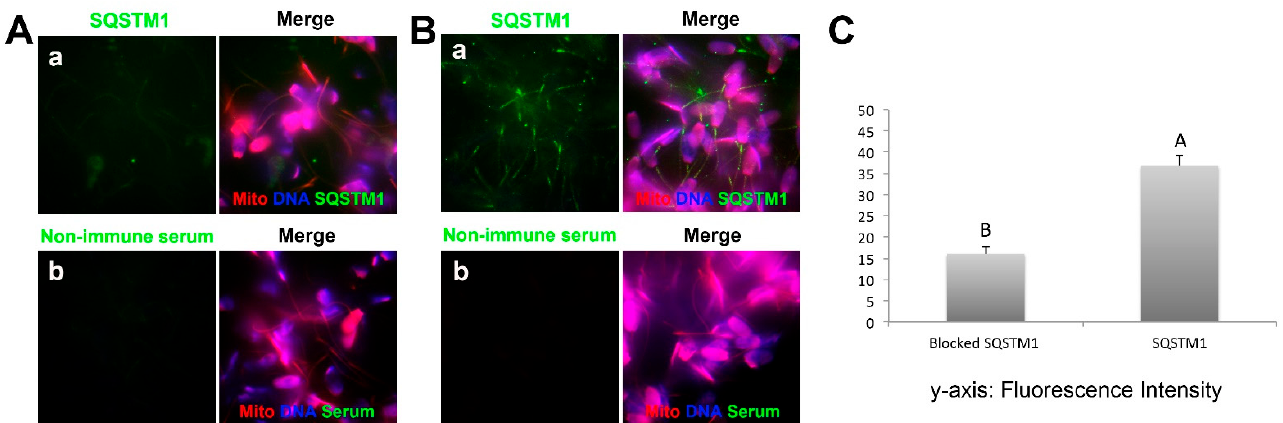
Figure 6. Inclusion of an isospecific antibody into sperm-oocyte extract co-incubation mixture prevents the binding of ooplasmic SQSTM1 to sperm mitochondria. Spermatozoa treated with lysolecithin and DTT were co-incubated with porcine oocyte extracts for 4 h with or without the addition of anti-SQSTM1 antibody, then washed and processed for immunofluorescence with the same antibody or with non-immune mouse serum (control). Such treatment prevented oocyte-extract derived SQSTM1 from binding to sperm mitochondria ( Aa ), while in a positive control sample (control mouse serum addition to the extract), SQSTM1 was detectable on sperm mitochondria at the end of sperm-extract co-incubation ( Ba ). No significant signals were detected with non-immune serum in negative control for immunofluorescence ( Ab , Bb ). Original magnification: 1000×. ( C ) Relative pixel intensity values of SQSTM1 fluorescence in the sperm mitochondrial sheath after sperm-oocyte extract co-incubation with/without the addition of anti-SQSTM1 antibody. The fluorescence intensity of ooplasmic SQSTM1 binding to sperm mitochondria was significantly lower in sperm-extract co-incubation blocked with an anti-SQSTM1 antibody. Values are expressed as the mean of fluorescence intensity ± SEM. Different superscripts A and B in the diagram denote significant differences at p < 0.05.